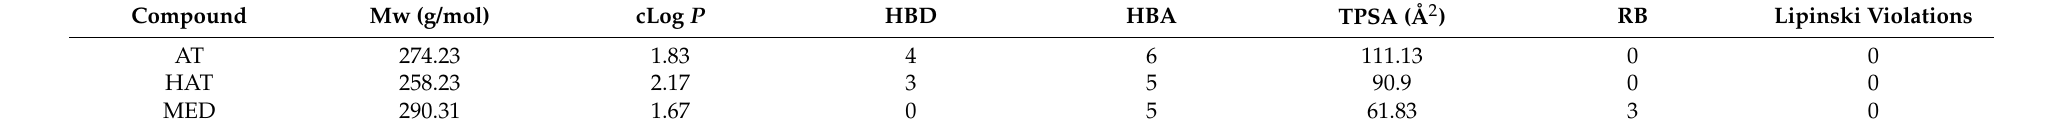
Table 6. Physicochemical parameters and Lipinski violations of the